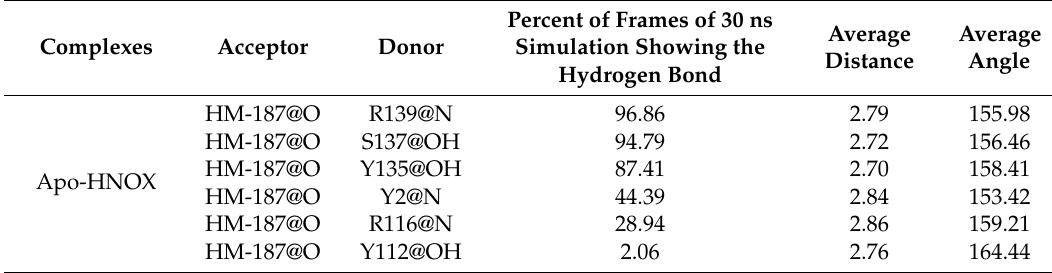
Figure 6. Binding modes of ( a ) 5c NO-HNOX, ( b ) 6c NO-HNOX, ( c ) O 2 -HNOX and ( d ) CO-HNOX complexes with heme carboxyl groups. The x-axis represents the time (ns) while the y-axis shows the heme (HM) propionic moiety (O1A, O2A, O1D, O2D) and critical binding pocket residues atoms interacting by hydrogen bonds. Yellow color illustrates the presence of hydrogen bond while black color represents absence. Table 1. Comparison of the apo-HNOX and HNOX-NO/O 2 /CO-ligated complexes (5c, 6c heme coordination states) hydrogen bond interactions of the heme propionic moiety with binding pocket residues.